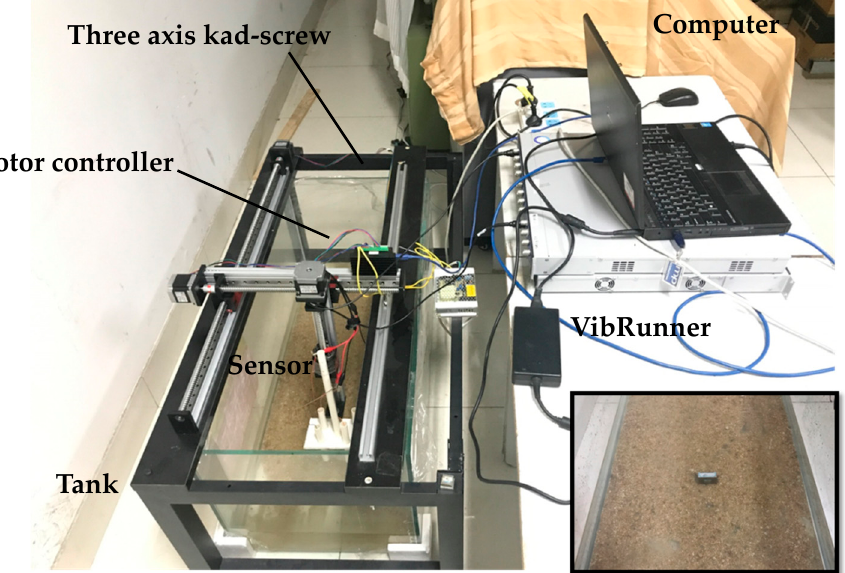
Figure 2. The active electrolocation test device: the sensor was attached to the tip of a stick whose planar motions were controlled by three-axis ball screw. The scene inside the water tank is shown in the lower right corner.